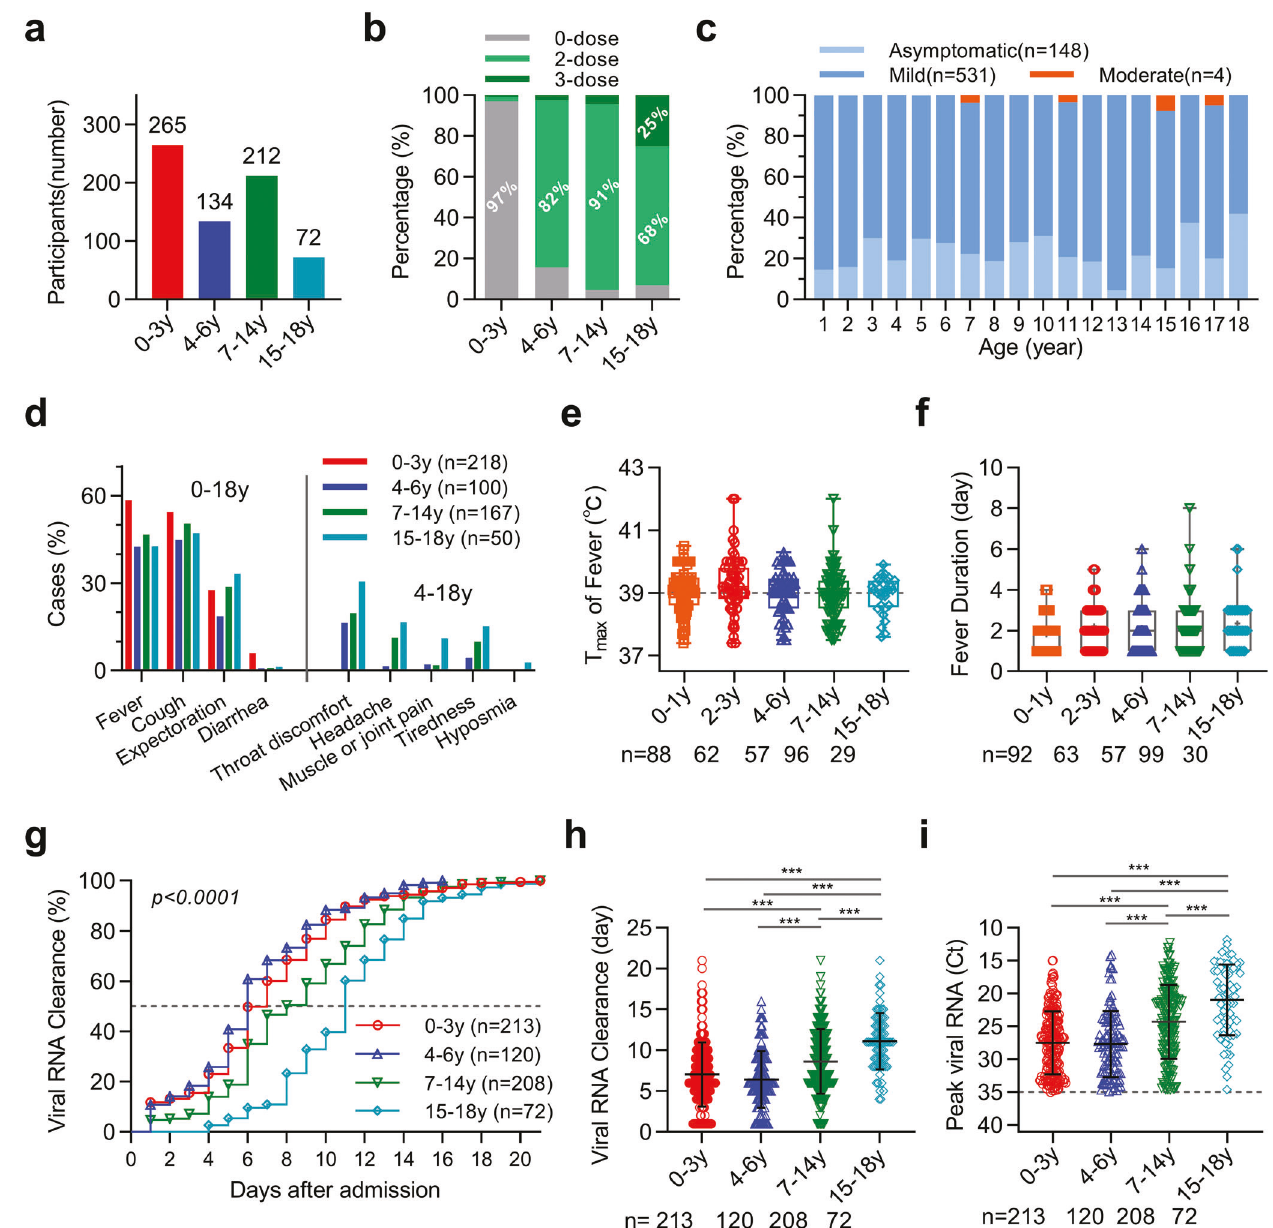
Fig. 1 Clinical characteristics of patients aged 0 – 18 with the SARS-CoV-2 Omicron subvariant BA.5.2 in Guangzhou. a The number of pediatric and adolescent patients with the BA.5.2 strain of COVID-19 in four age groups. Patient numbers are shown above each group. b The percentages of patients in four age groups who have received a SARS-CoV-2 vaccine. c The percentages of asymptomatic, mild, and moderate cases of the BA.5.2 strain of COVID-19 in patients aged 0 – 18 years. d The rates of fever, cough, expectoration, and diarrhea in patients aged 0 – 18 years and the rates of throat discomfort, headache, muscle or joint pain, tiredness, and hyposmia in patients with BA.5.2 in patients aged 4 – 18 years. e , f Fever peaks and fever duration (in days) in BA.5.2 patients of four age groups. Patient numbers are shown below each group. g The kinetics of SARS-CoV-2 RNA clearance. Cumulative viral clearance (%) is shown. The abscissa represents the time required for negative conversion of nucleic acid and the ordinate represents the percentages of patients with negative nucleic acid. The calculation method for viral RNA clearance was: viral RNA clearance (%) = the number of patients whose nucleic acid turned negative/total number of patients × 100%. P - values (derived by log-rank [Mantel-Cox] test) are shown. h Time for viral clearance. i . Peak viral load. The maximum viral load (represented by the lowest Ct value) of each patient during hospitalization was identi fi ed. Patient numbers are shown below each group. Each dot represents one patient. The Mann – Whitney U-test was used for ( e ), ( f ), ( h ) and ( i ); p -values <0.05 were deemed statistically signi fi cant (* p < 0.05, ** p < 0.01, *** p < 0.001). 0 – 3 y, patients aged 0 – 3 years old; 4 – 6 y, patients aged 4 – 6 years old; 7 – 14 y, patients aged 7 – 14 years old; 15 – 18 y, patients aged 15 – 18 years old. 0-dose, not vaccinated; 2-dose, received two doses of the vaccine; 3-dose, received three doses of the vaccine. Ct, cycle threshold; RNA, ribonucleic acid; SARS-CoV-2, severe acute respiratory syndrome coronavirus